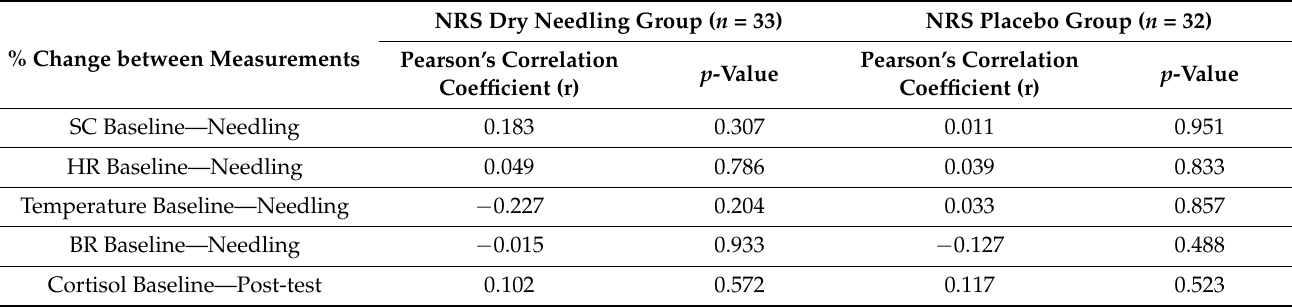
Needling and Post-1 with State Anxiety; and in the BR variable in the % Change Post-1 to Post-2 with the Total PCS ( p = 0.024, r = 0.393). The results for the Placebo Group are shown in Table 6, and indicate a significant negative correlation for the BR in the % Change between Post-1 and Post-2 with State Anxiety ( p = 0.047, r = − 0.354), and between % Change Cortisol and the BDI-II ( p = 0.021, r = − 0.407), State Anxiety ( p = 0.018, r = − 0.416), and Trait Anxiety ( p = 0.037, r = − 0.371). Table 4. Correlations of Numeric Rating Scale for Pain with % Change of the Physiological variables and Cortisol. NRS Dry Needling Group ( n = 33) NRS Placebo Group ( n = 32) % Change between Measurements Pearson’s Correlation Pearson’s Correlation p -Value p -Value Coefficient (r) Coefficient (r)